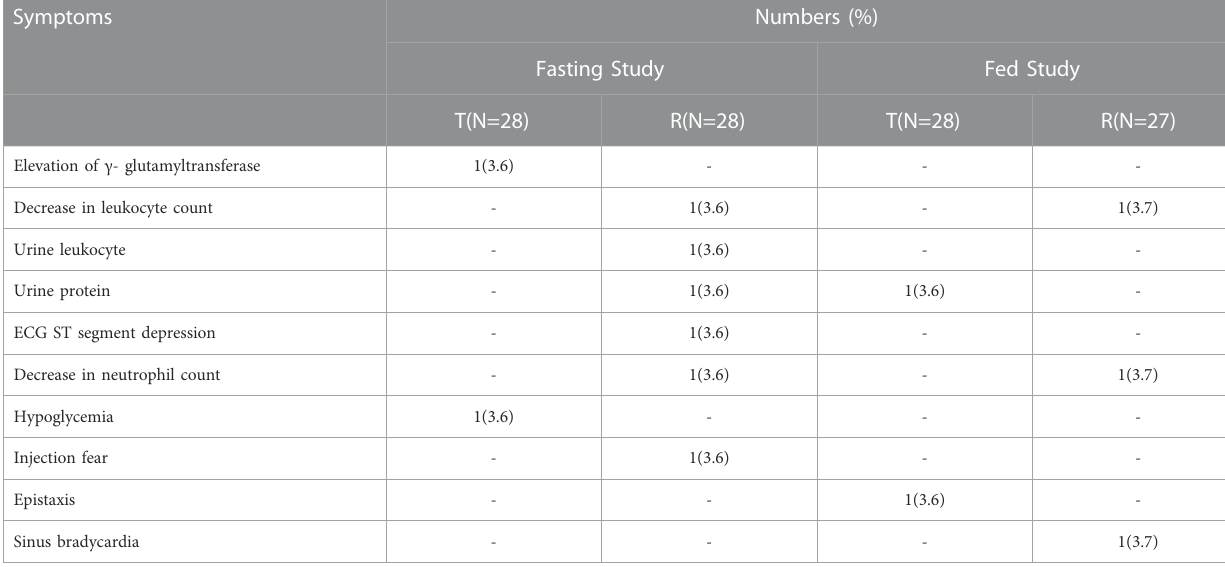
TABLE 6 Summary of the number and types of adverse events that occurred in fasting and fed